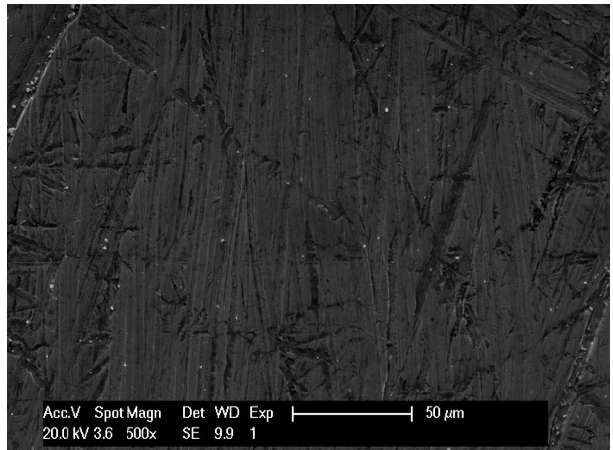
Figure 4. Surface of the steel substrate after the 100 ◦ C tube furnace deposition process.